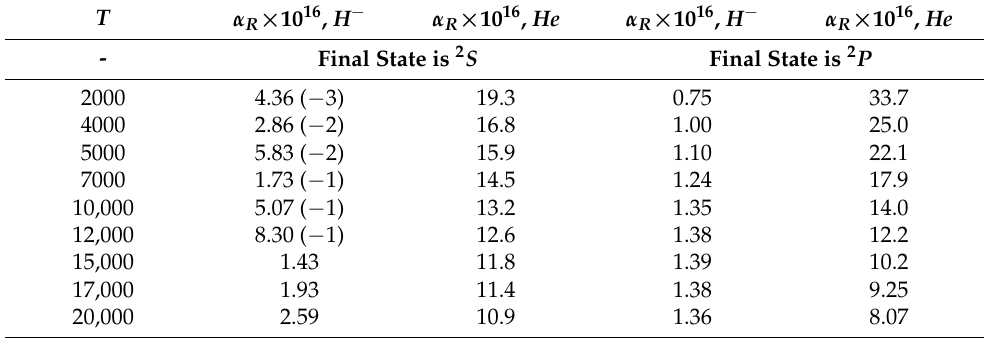
Table 9. Recombination rate coefficients (cm 3 /s) to (1s1s) 1 S state from 2 S and 2 P